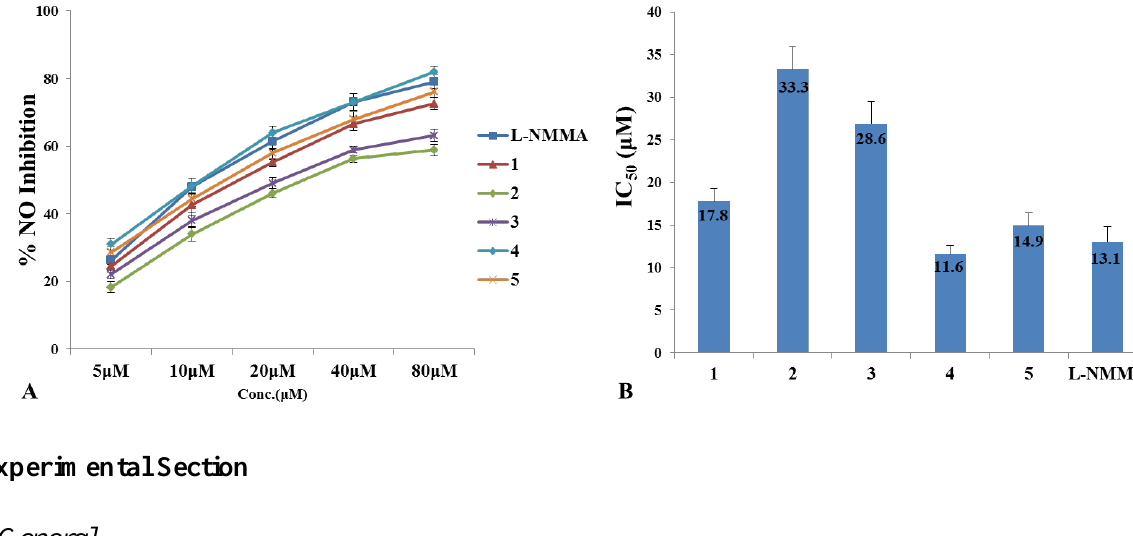
Figure 4. Inhibitory activities of compounds 1 – 5 on NO production in LPS-induced RAW 264.7 cells. ( A ) Inhibitory effects on NO production of compounds 1 – 5 and positive control ( L -NMMA). All results are expressed as the mean ± S.D. of three independent experiments, each one performed in triplicate. ( B ) IC of compounds 1 – 5 and the positive 50s